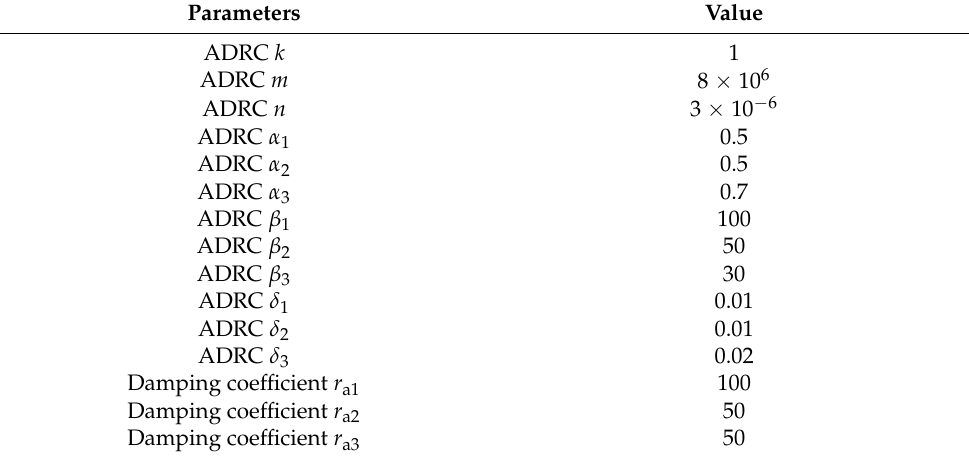
Table 2. Control coefficients of